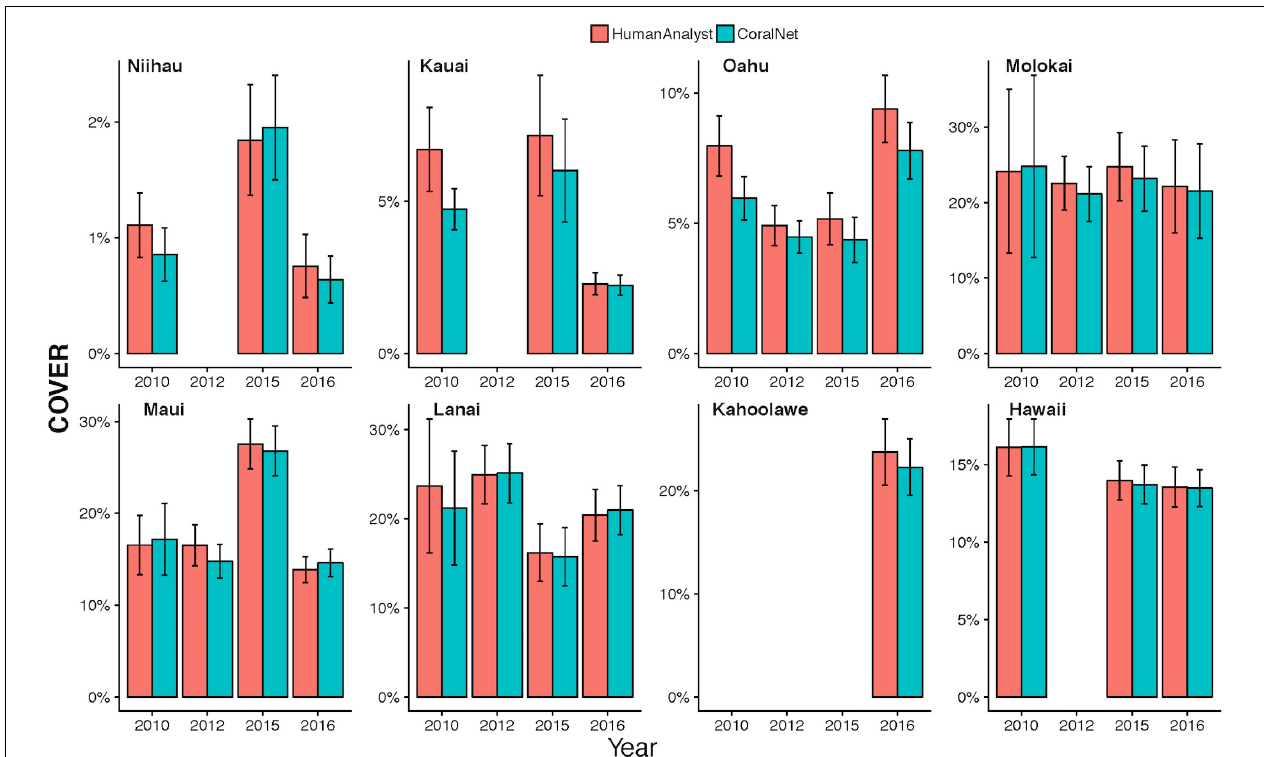
FIGURE 6 | MHI Island-scale coral cover per year from human analysts and CoralNet. Columns represent annual mean and standard error of coral cover by island and year. CoralNet estimates were derived from the “BASE-HABITAT” classification ( Supplementary Table S2 ). Numbers of sites per island and year are shown in Table 1 , but vary between 9 and 8 for